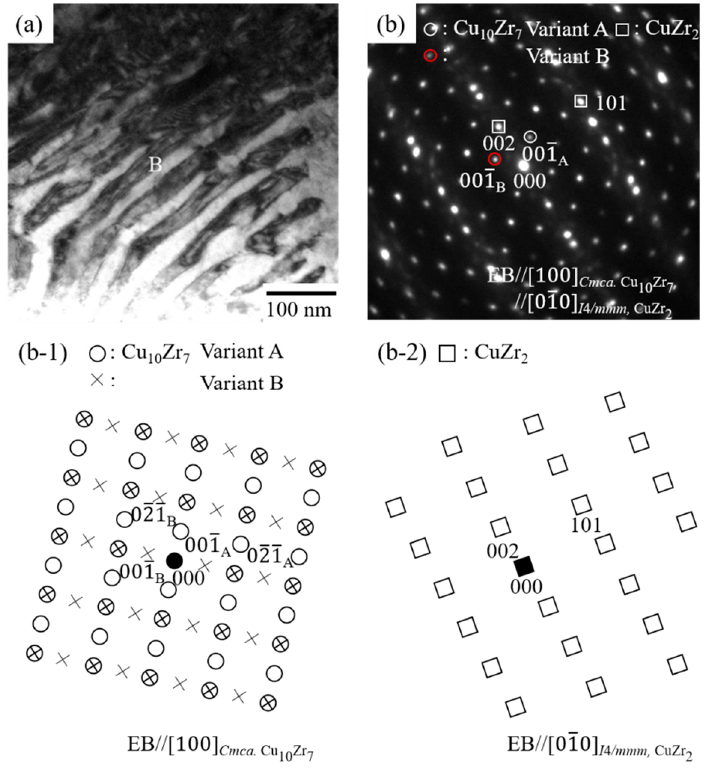
Figure 7. ( a ) Bright field image of 10th cycled equiatomic CuZr alloy, ( b ) electron diffraction pattern is taken from the ( a ), and ( b -1)-( b -2) schematic of electron diffraction patterns in ( b ). (The measured maximum temperature at DSC measurement is 500 °C.).